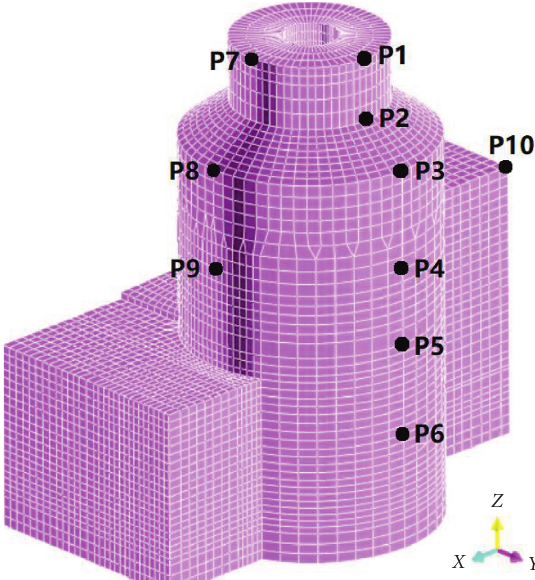
Figure 7: The location of reference points.